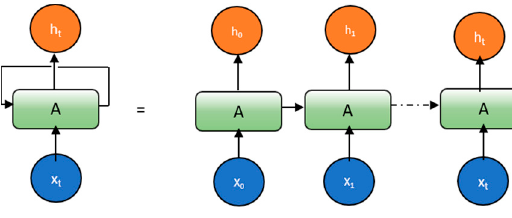
Figure 29. An unrolled RNNs.